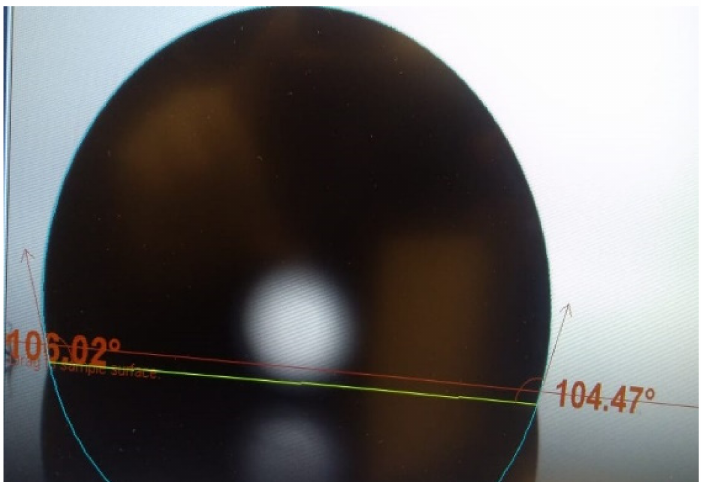
Figure 11. Contact angle between the liquid and solid